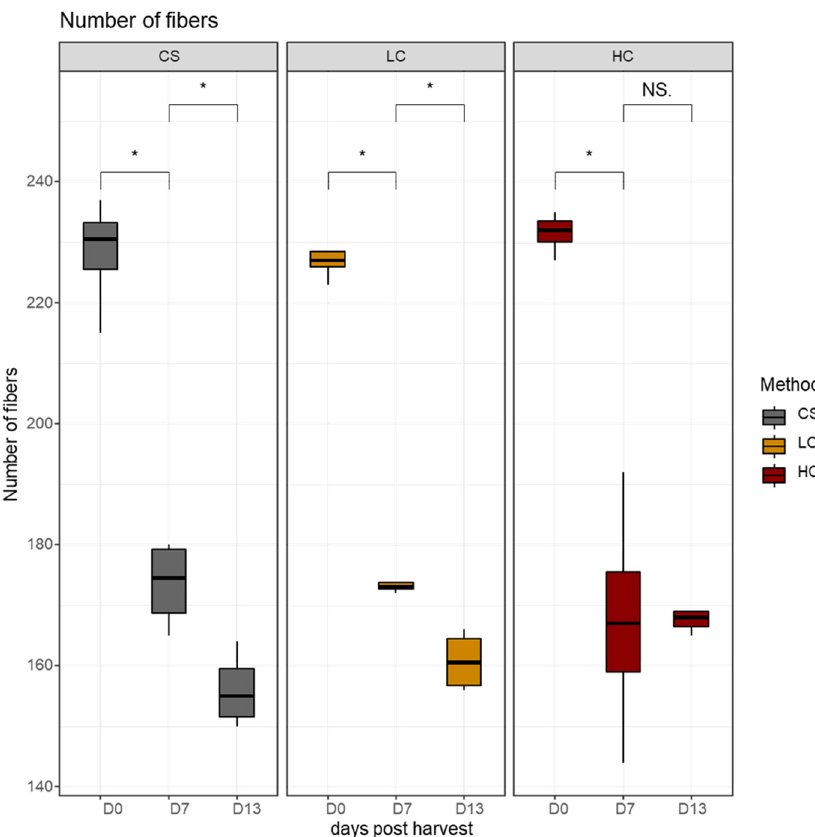
Figure 5. Number of white muscle fibers in the 10 µ m 2 area in sampling days per harvest method. CS (gray): Control group, LC (orange): Low current group, HC (red): High current group. Superscripts indicate statistically significant differences between days in each harvest method (NS. = 1, *: p < 0.05).